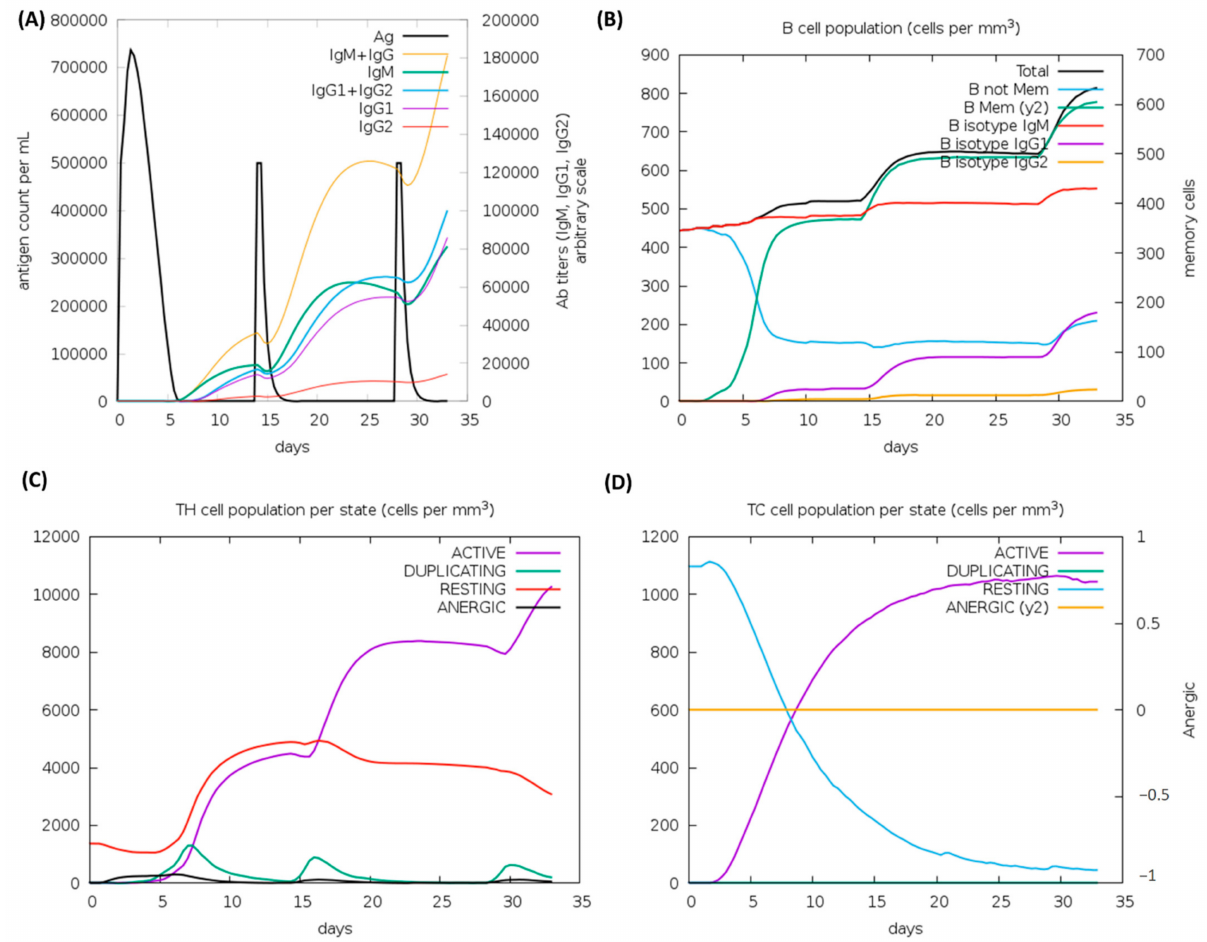
Figure 8. C-ImmSim analysis of a chimeric peptide immune simulation ( A ) Antibody production after antigen injections (black vertical lines); subclass immunoglobulins are displayed in the form of colored peaks ( B ) The alterations to B-cell populations following three injections. ( C ) Changing populations of T-helper cells, and ( D ) the number of T-cytotoxic cells per state following an injection. T-cells in the resting state are not exposed to antigens, while those in the anergic state are tolerant to antigens due to repeated